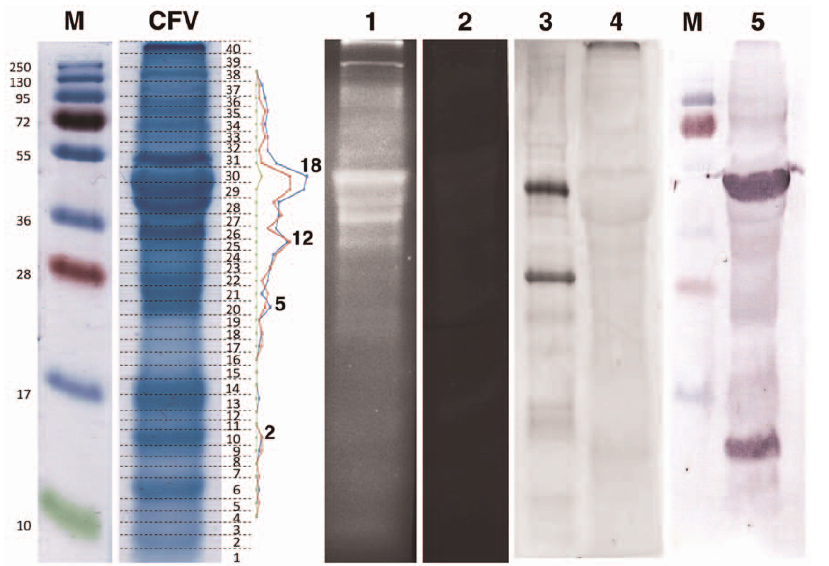
Figure 2. C.fleckeri venom proteins. Total protein from CFV in a Coomassie-stained 15% SDS-PAGE gel. Lanes were divided into 40 gel slices (dotted lines) and subjected to in-gel tryptic digest before LC-MS/MS analysis. Markers ( M ) are indicated and the numbering system used for gel slices. CFV proteins separated using SDS-PAGE and stained in-gel with fluorescent dyes reactive to glycans or phosphate groups (Lanes 1–4). Glycan analysis showed fluorescence in bands corresponding to CfTX proteins (Lane 1) and no fluorescence in the negative control (Lane 2). No phosphorylation was observed except in band 40 (Lane 4; positive control in Lane 3). Western blot analysis using polyclonal antibodies for CfTX-1 and -2 showed hybridisation in two bands corresponding to the highest scoring Mascot identifications for these proteins and in the region corresponding to approximately 12 kDa (lane 5). No other bands were positive for these proteins despite their identification in MS/MS analysis. The spectral counts for proteins from this toxin family identified using Mascot are displayed adjacent to the band numbering (blue, red and green lines for CfTX-1, CfTX-2 and CqTX-A resp.). Actual spectral counts for a selection of CfTX-1 points are shown for reference.